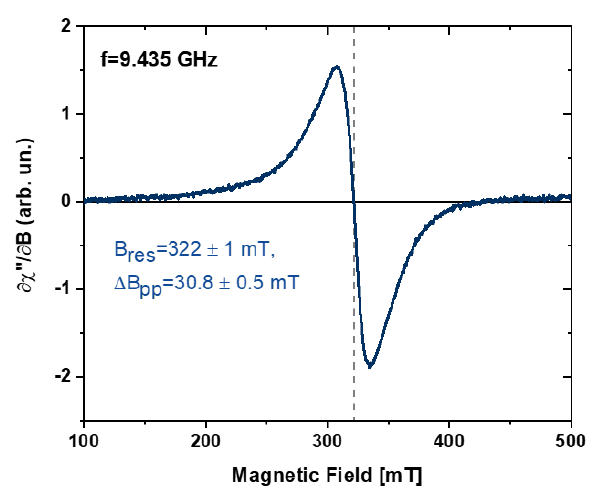
Figure 7. The ferromagnetic resonance spectrum measured at 9.435 GHz of a FeRh nanoparticles solution in acetone at room temperature. B res is the resonance field (dotted line), ∆ B pp is the peak-to-peak linewidth.